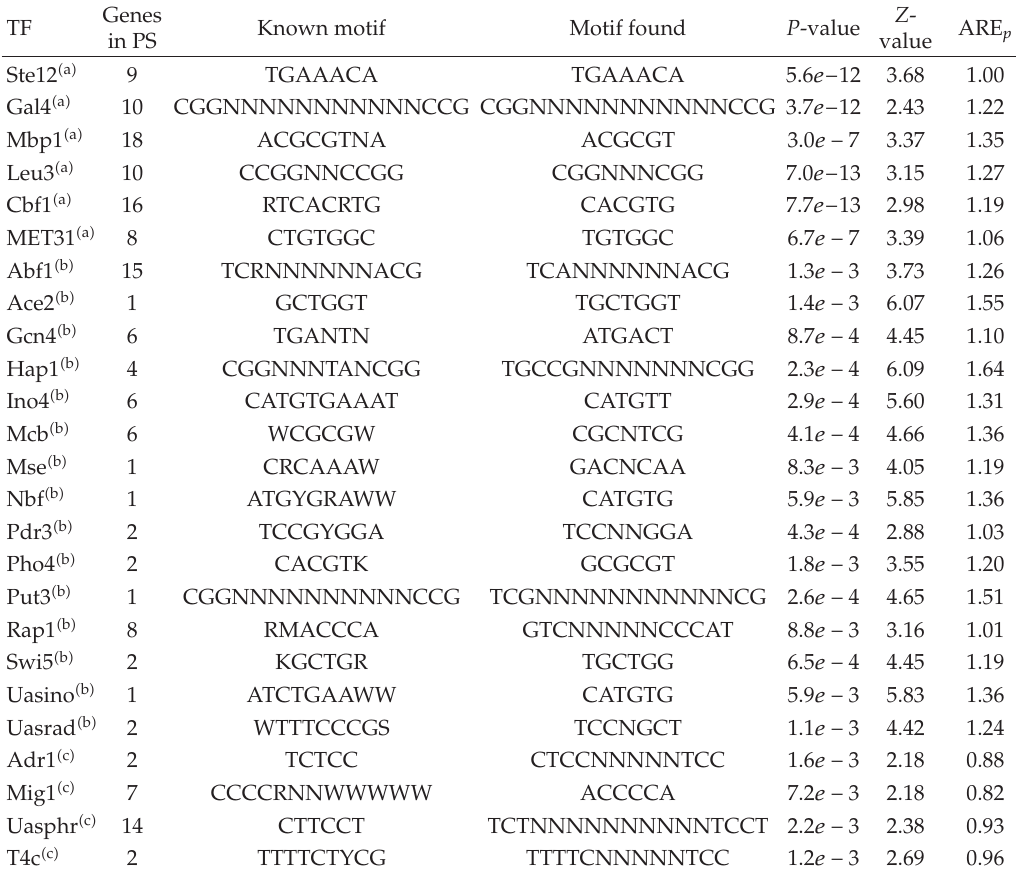
Table 2: Comparison between the known motifs and the motifs found using our method. Di ff erent parameter threshold settings are used in our motif finding. (cid:2) a (cid:3) P -value in a magnitude of 10 − 6 (cid:2) after Bonferroni adjustment (cid:3) , ARE p (cid:8) 1 . 0, and Z -value (cid:8) 2.0; (cid:2) b (cid:3) P -value (cid:8) 0.01 (cid:2) without Bonferroni adjustment (cid:3) , ARE p (cid:8) 1 . 0, and Z -value (cid:8) 2.0; (cid:2) c (cid:3) P -value (cid:8) 0.01 (cid:2) without Bonferroni adjustment (cid:3) , ARE p (cid:8) 0 . 8, and Z -value